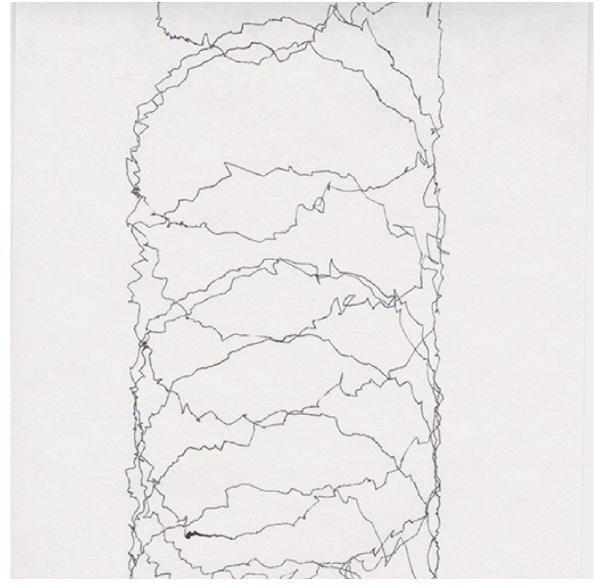
Figure 3 | Opener Drawing Nr. 2 (excerpt). A denser spiral.